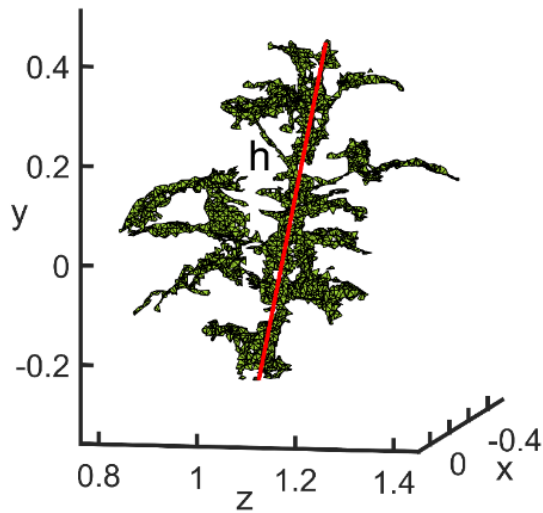
Figure 18. Plant height calculation diagram.